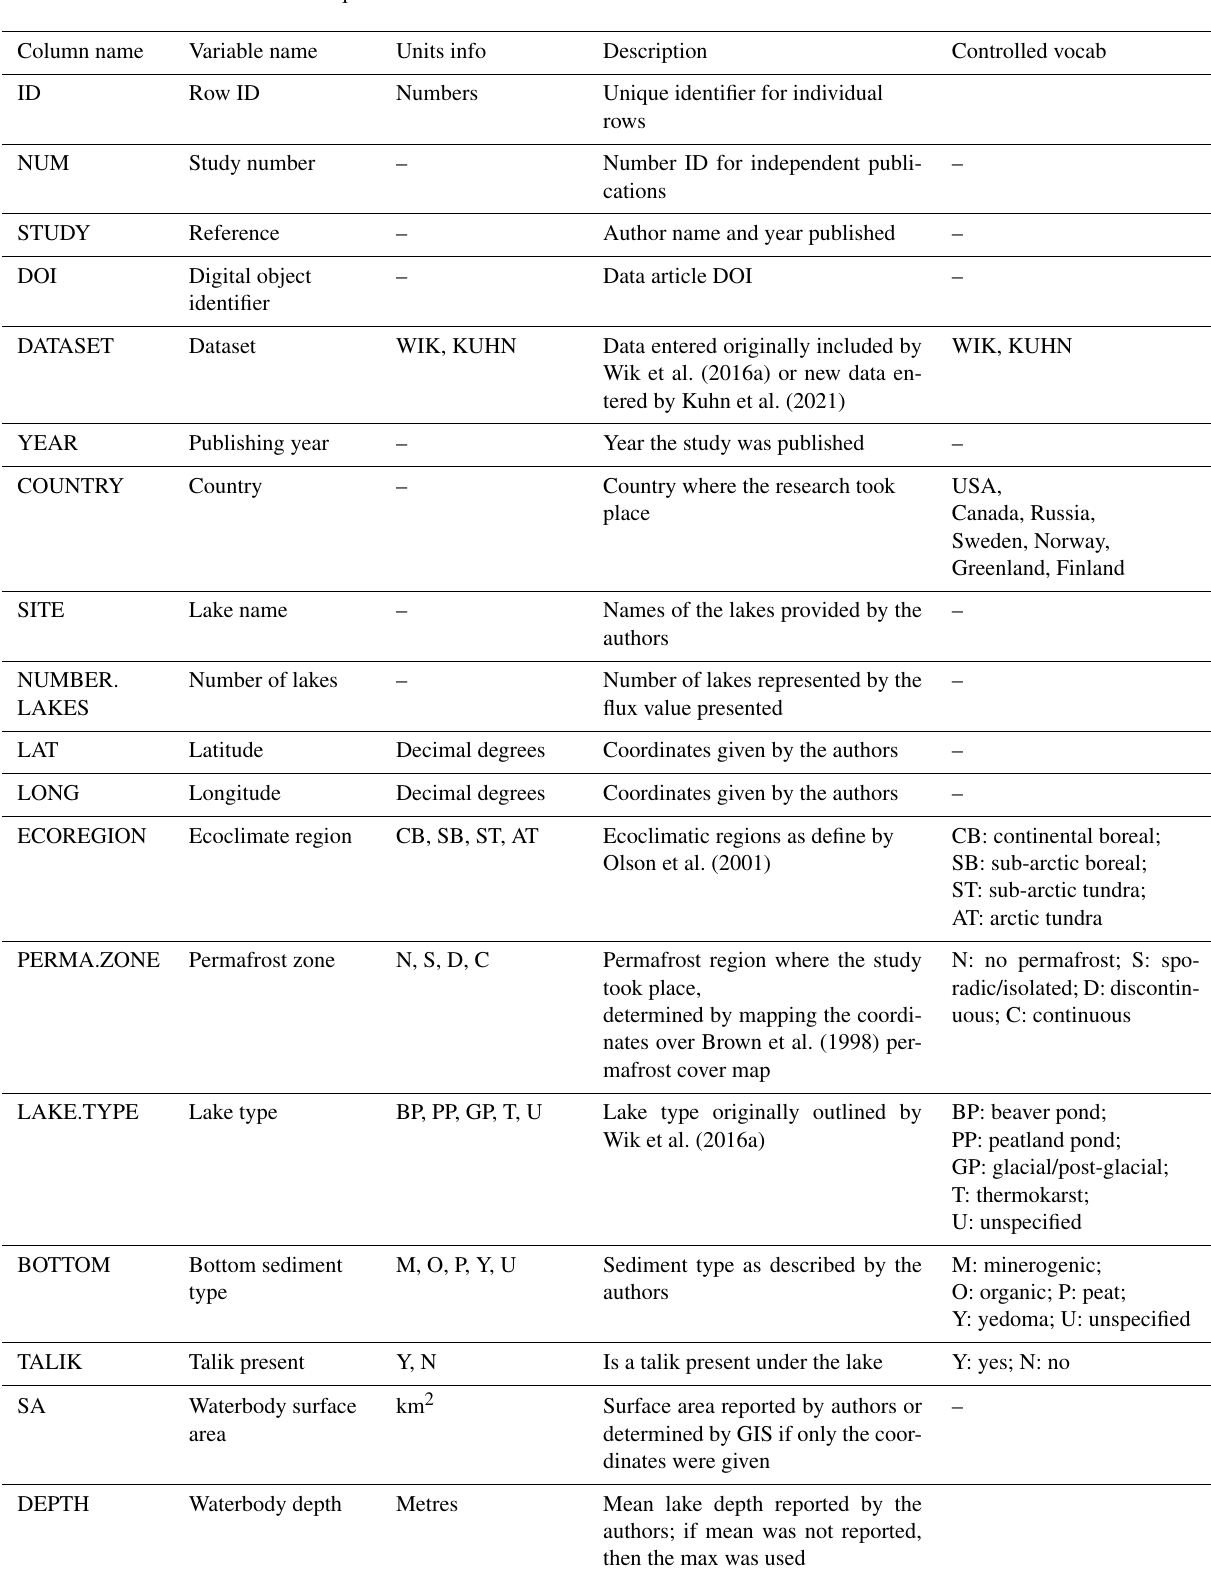
Table 2. Attribute information for the aquatic flux